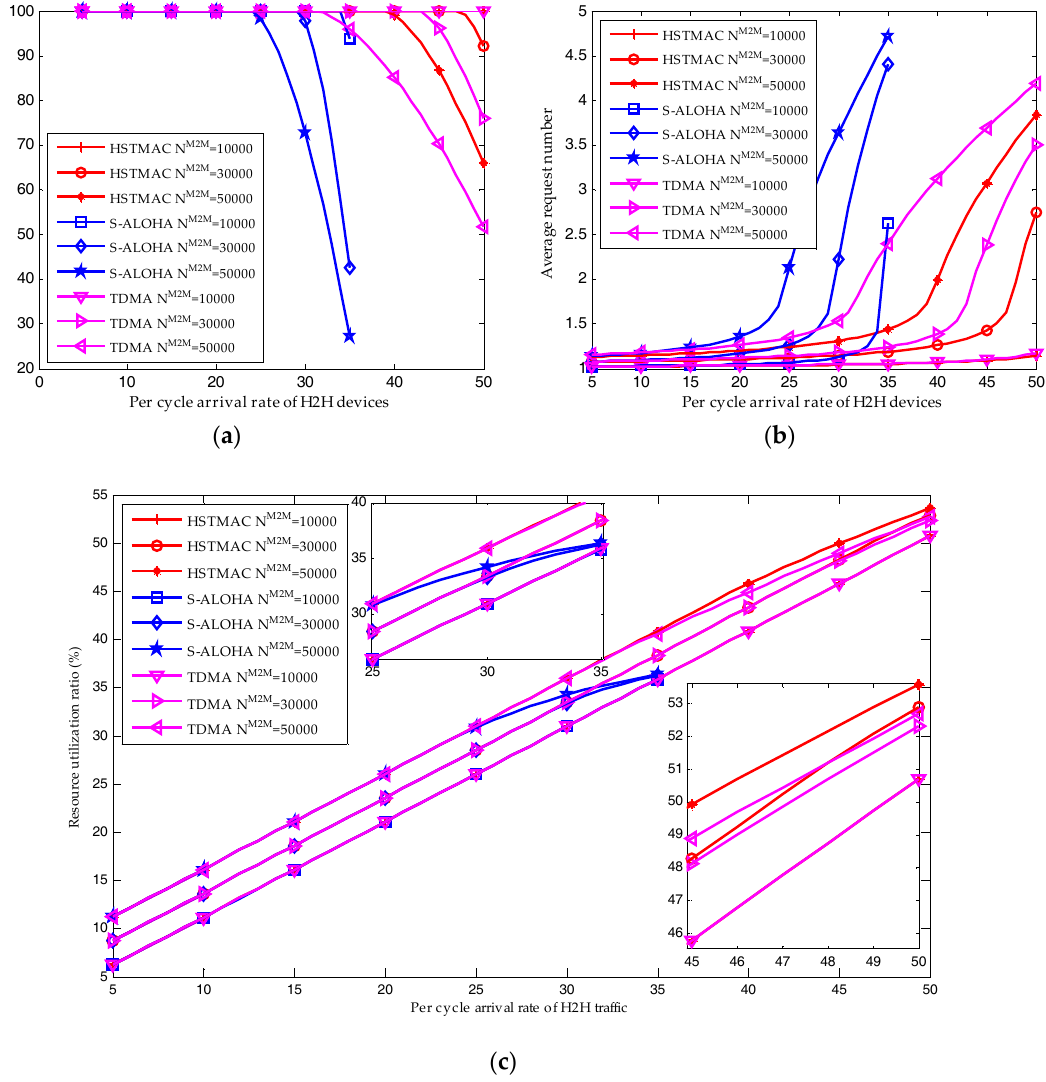
Figure 10. Performance comparison of the proposed HSTMAC protocol with pure S-ALOHA protocol and pure TDMA protocol (Q = 10, W BO = 0): ( a ) Average success probability of M2M traffic; ( b ) Average request number of M2M traffic; ( c ) Resource utilization ratio.